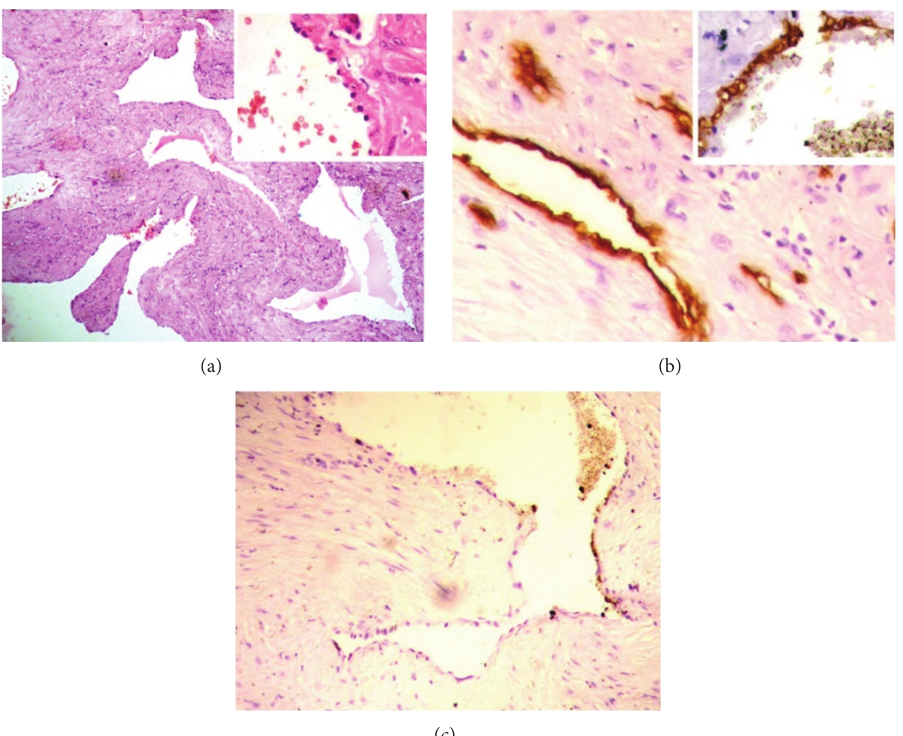
Figure 4: (a) Histopathological image of the tumor shows that the vascularity of the tumor and the blood vessels are arranged in retiform pattern (H&E staining, magnification × 10). The same section under high magnification shows classical hobnail type of endothelial cells projecting into the lumen of the vascular channels (magnification × 40, window). (b) Immunohistochemical staining of sectioned tumor indicates that the tumor cells are positive for CD34 (magnification × 10, × 40 (top right window)) and occasionally positive stain for Ki-67